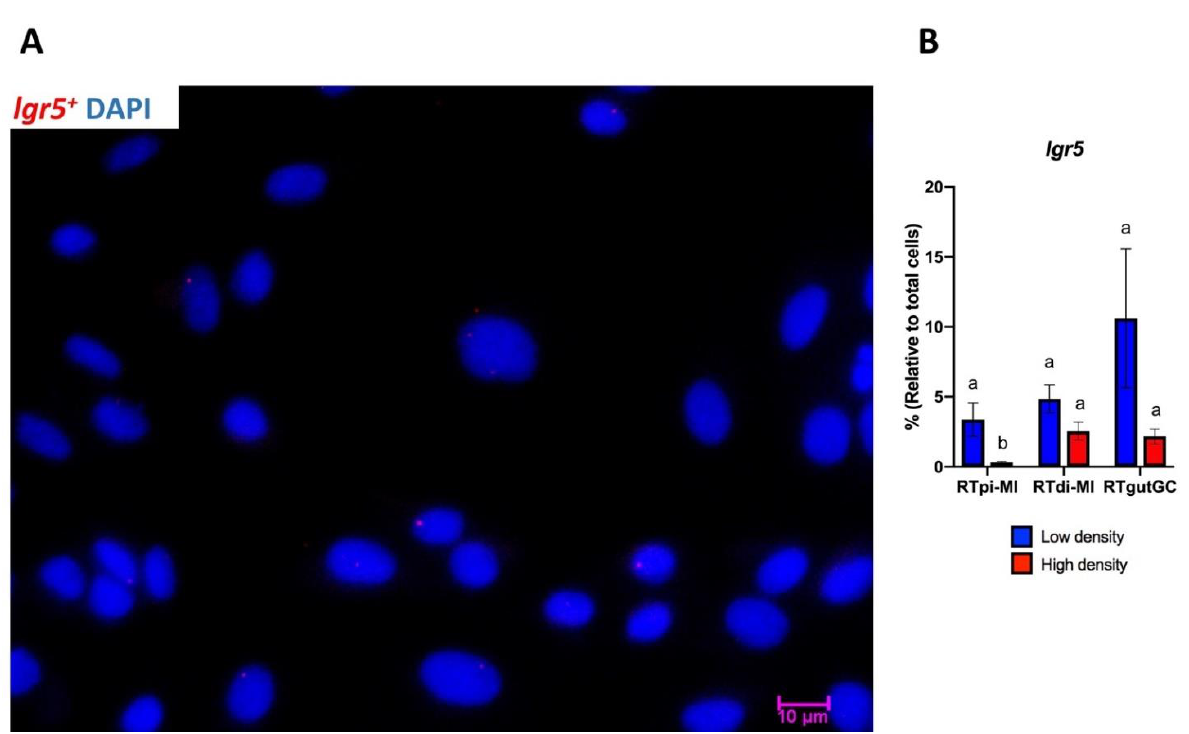
Figure 5. Lgr5 + cell rates at low and high seeding density. ( A ) Representative microphotograph of lgr5 + cells (red) at low and high seeding density. DAPI was used to stain the cell nucleus (blue). Scale bar, 10 µm. ( B ) lgr5 + cell rates at low (blue bars) and high (red bars) seeding densities relative to total cell count. Data are shown as the mean ± SD of 3 independent experiments. Different superscript letters indicate statistical significance.